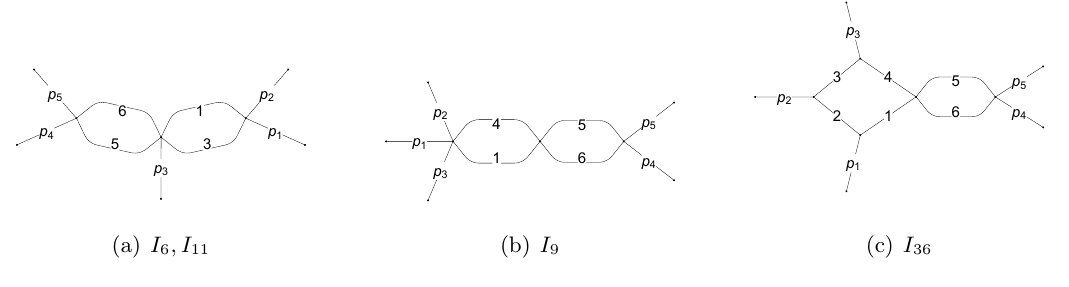
Figure 3 . Factorized